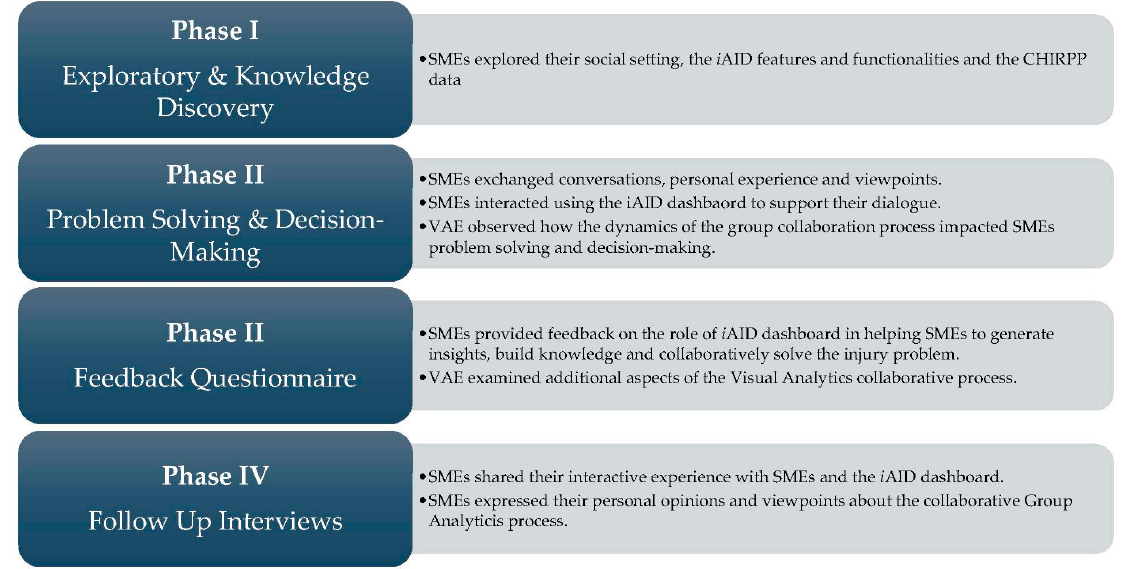
Figure 4. Four phases of the collaborative visual analytics process.